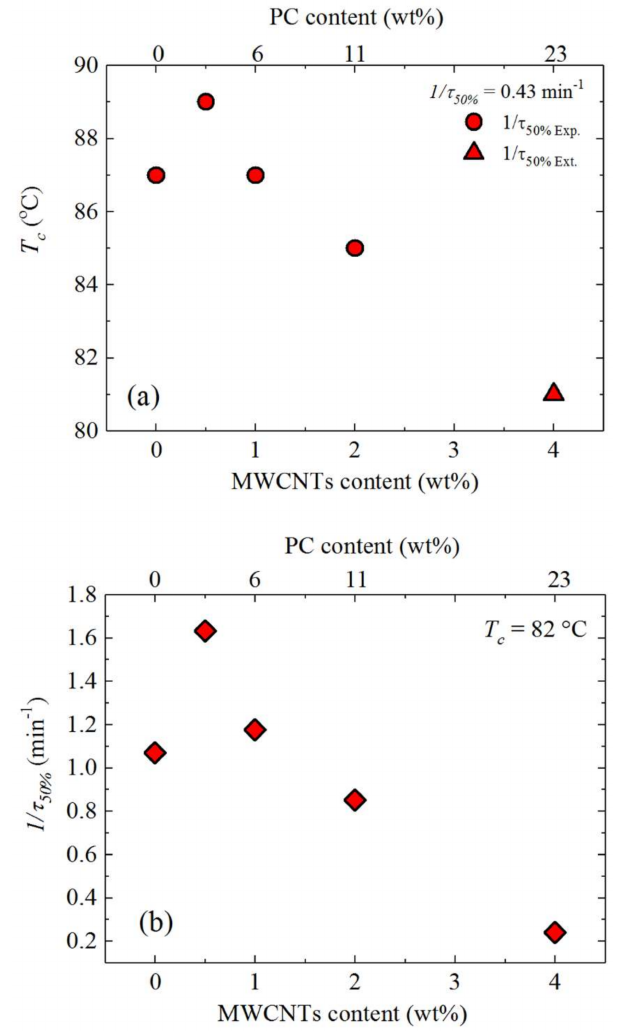
Figure 12. ( a ) Crystallization temperature as a function of MWCNTs content at constant 1/ τ 50% = 0.43 min − 1 ; ( b ) overall crystallization rate as a function of MWCNTs content at constant T c = 82 ◦ C. The top x-axis indicates the PC